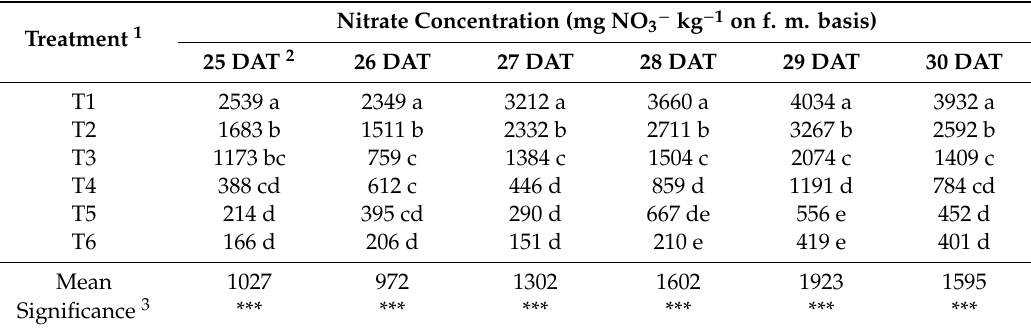
Table 10. Spring trial: nitrate concentration in lettuce on fresh matter basis. Treatment 1